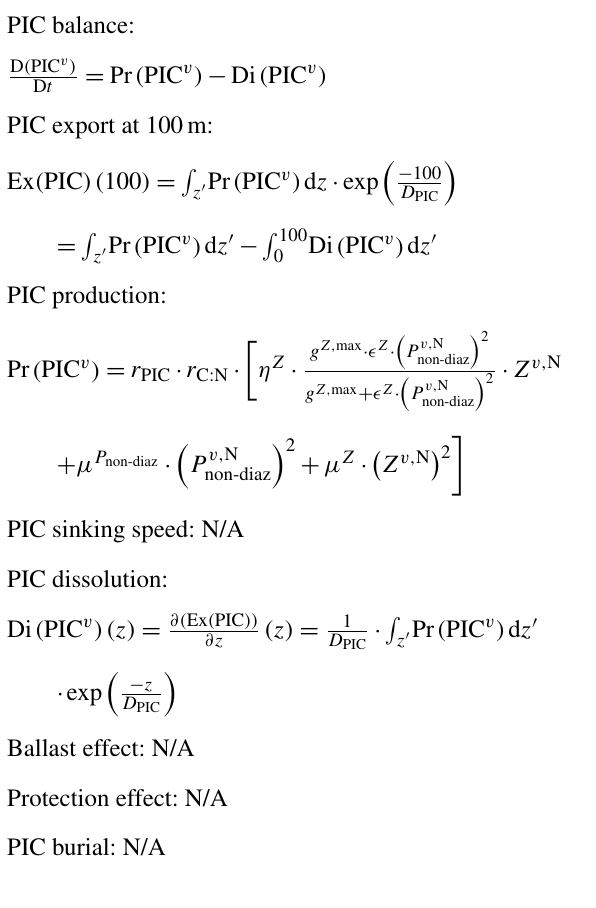
Table C9. OECO2 parameters.